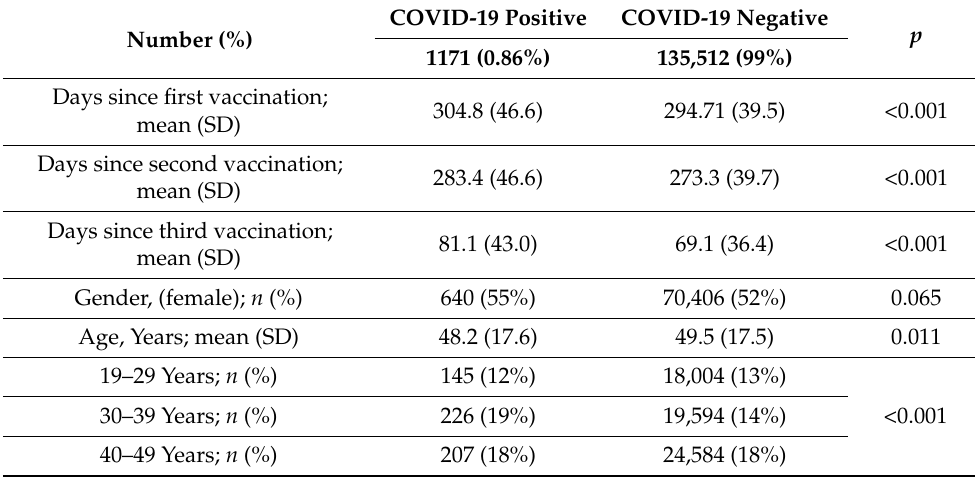
Table 1. Demographic and clinical characteristics of 136,683 subjects with Pfizer-BioNTech mRNA booster